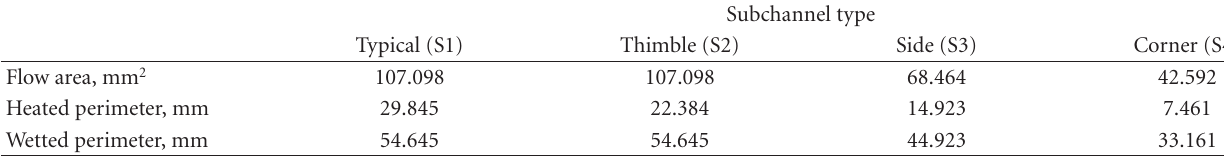
Table 2: Geometrical parameters of each subchannel